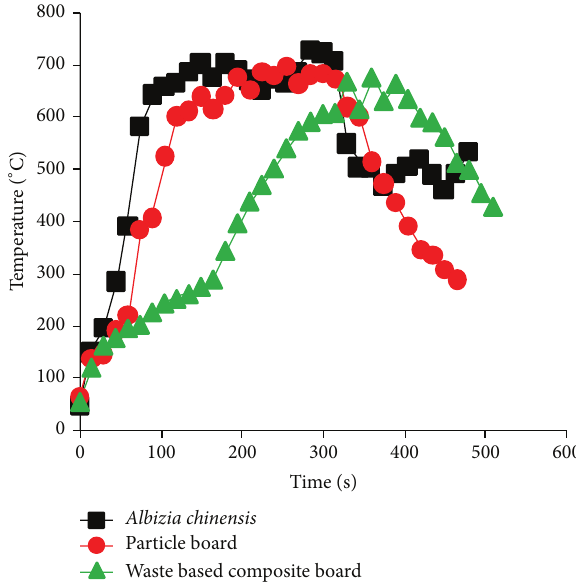
Figure 14: Changes in the rate of temperature increase in albasia wood, particle board, and the composite as a function of time. All samples were burned in the same